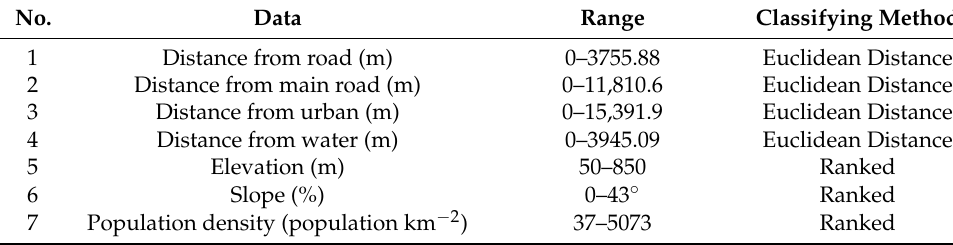
Table 3. Factors considered in driving force analysis for changes of LULC